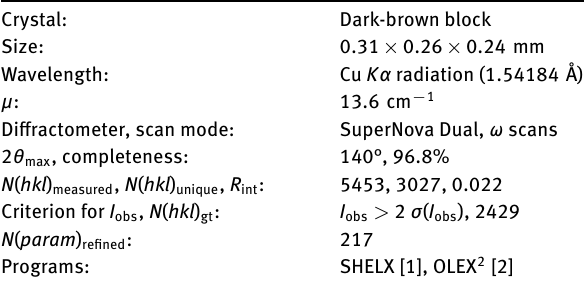
Table 1: Data collection and